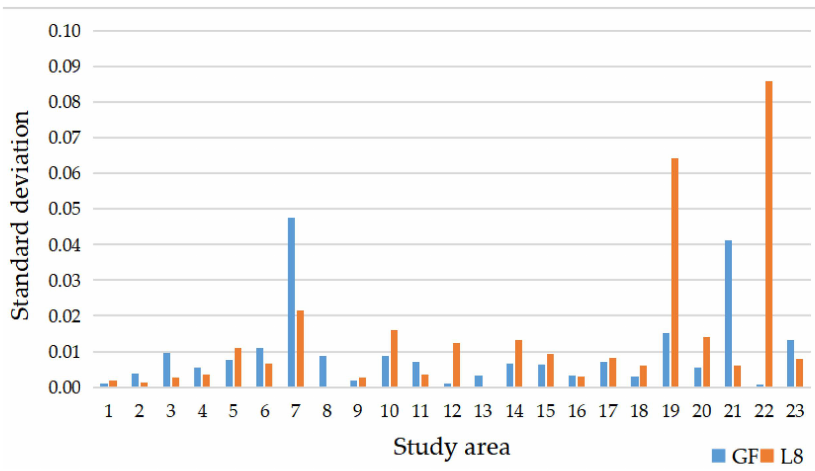
Figure 4. The standard deviation of F1 score for different processing levels in each study area.